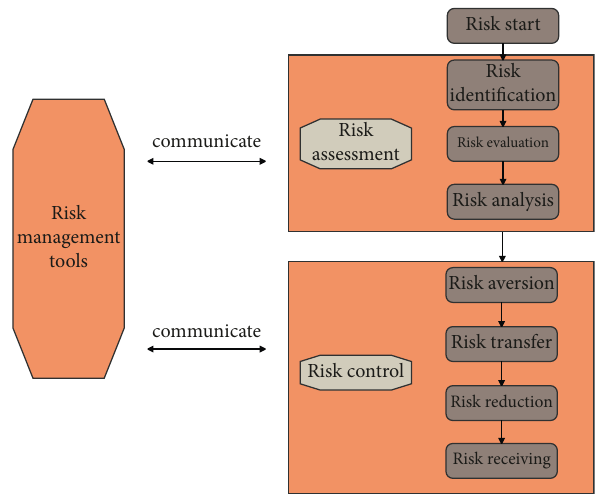
Figure 7: Risk management flow